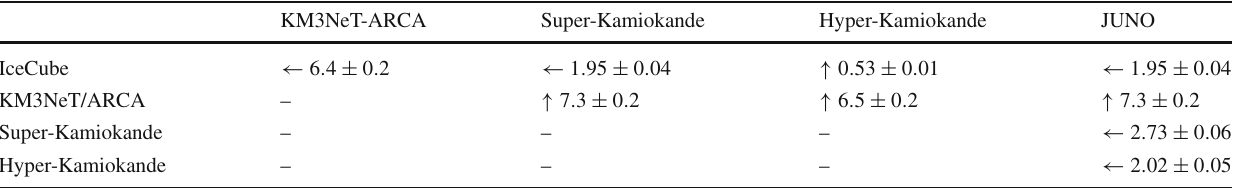
Table 2 Uncertainty δ t in milliseconds obtained with the chi-square method using ideal normalization of the detector neutrino light-curves. The detector pairs are listedin row and column names. The arrow points